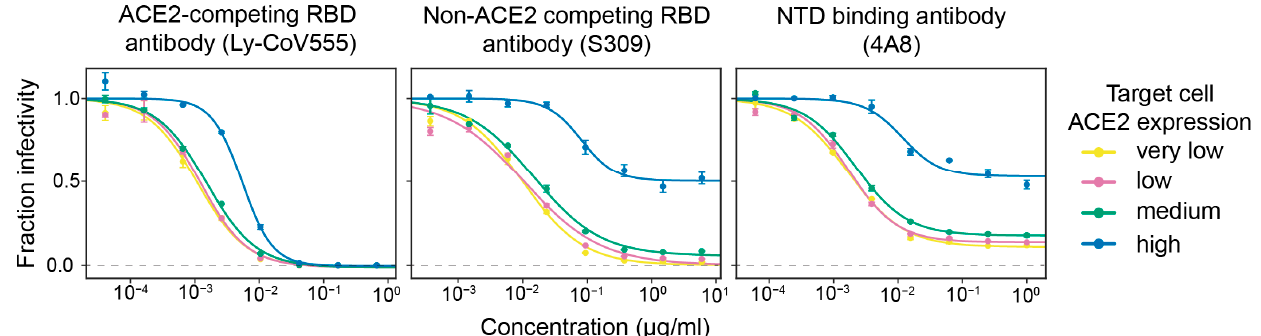
Figure 3. High ACE2 expression in target cells strongly reduces neutralization by monoclonal antibodies that bind spike epitopes outside the receptor-binding motif. Neutralization curves for three monoclonal antibodies that target different epitopes: Ly-CoV555 binds the RBD’s receptor-binding motif and competes with ACE2 binding, S309 binds a RBD epitope outside the receptor-binding motif, and 4A8 binds the NTD. The dashed gray line indicates zero infectivity. Neutralization assays were performed using D614G spike-pseudotyped lentiviral